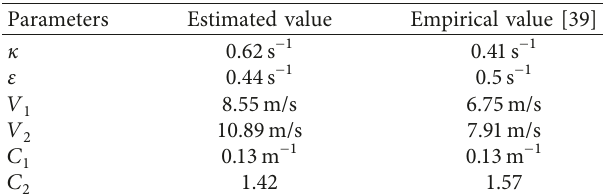
Table 4: Estimated value and empirical value of the parameters in